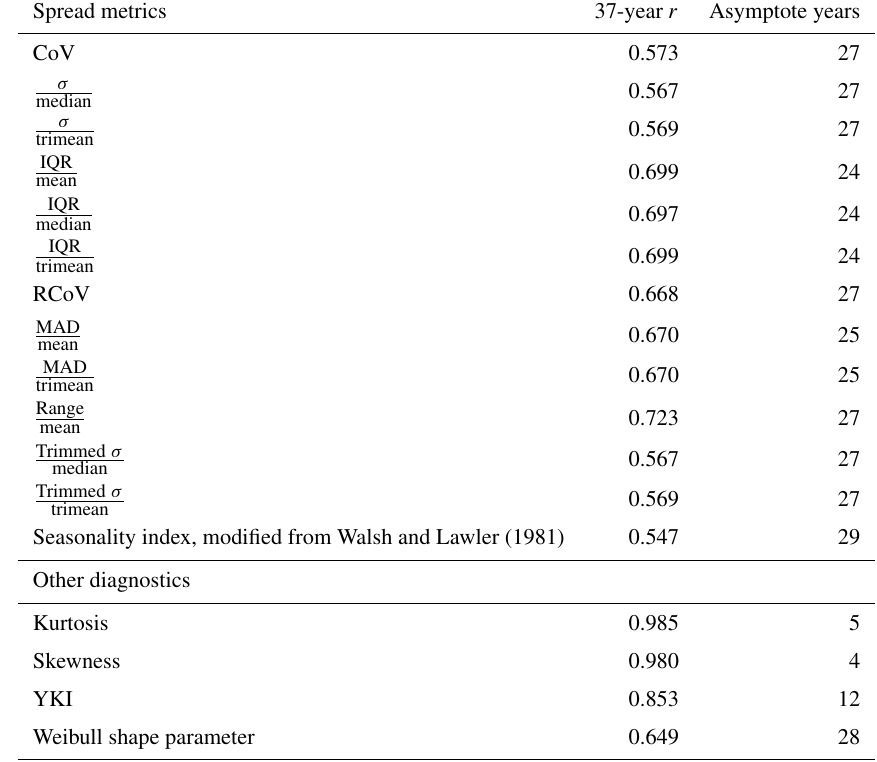
Table B4. As in Table 3, but with the calculated metrics, the associated correlations, and asymptote periods using annual-mean wind speed and energy production using the 195 r -filtered sites.